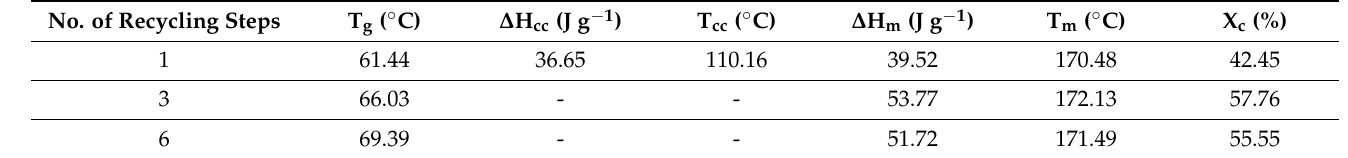
Figure 5. Overlay thermogram of the PLA material after undergoing 1, 3 and 6 mechanical recycling steps. Table 3. Thermal properties observed via DSC of the recycled PLA